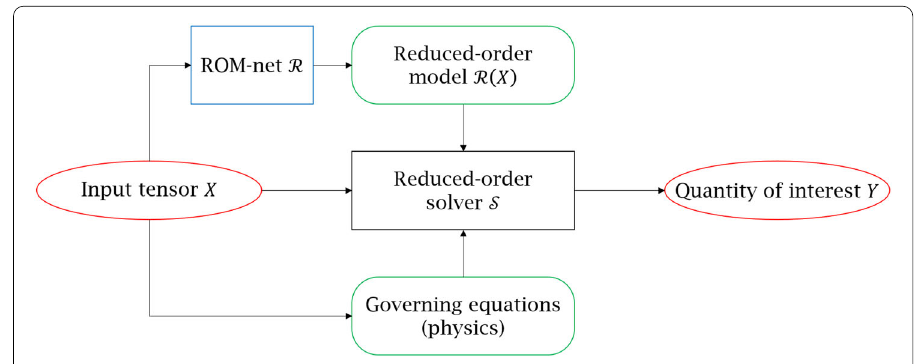
Fig. 1 Flowchart of model order reduction using a